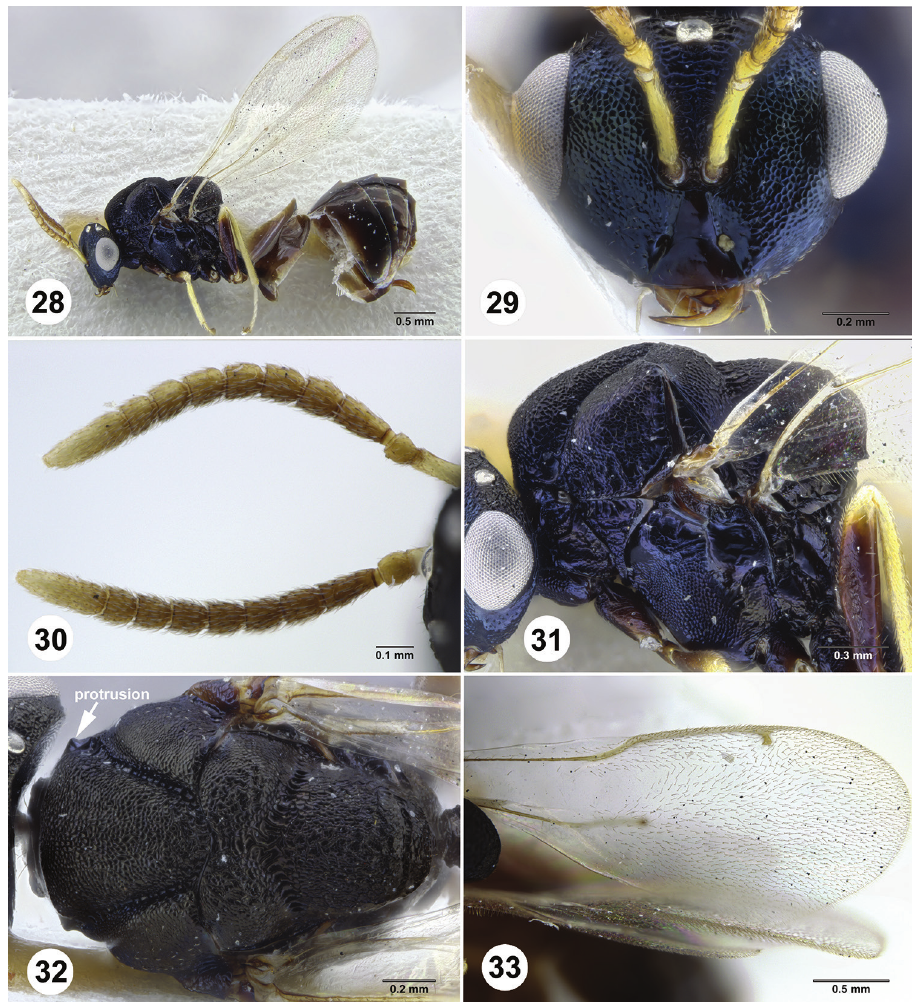
Figures 28–33. Hayatosema plicator . Holotype female: 28 habitus, lateral 29 head, anterior 30 antennae, dorsal 31 mesosoma, lateral 32 mesosoma, dorsal 33 fore wing,